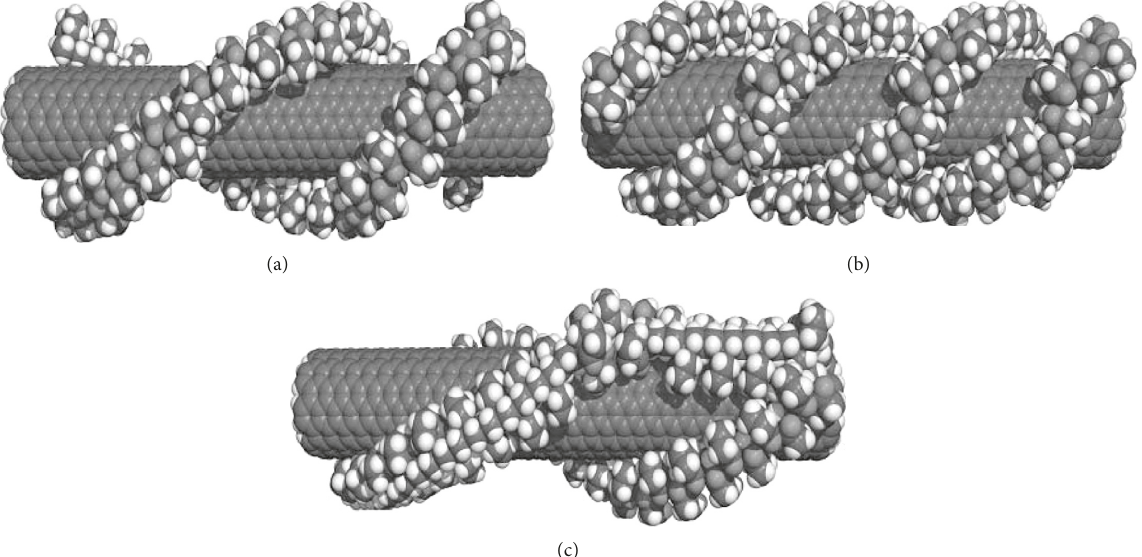
Figure 9: Three possible multihelical wrapping conformations of polyvinyl pyrrolidone around an individual single-walled carbon nanotube. (a) A double helix and (b) a triple helix. (c) Backbone bond rotations can cause a sharp bend, which allows multiple parallel wrapping strands to come from the same chain of the linear polymer. Low-backbone strain with high-surface area coverage is allowed for multihelical wrapping (adapted with permission from reference [175]; copyright 2001, Elsevier